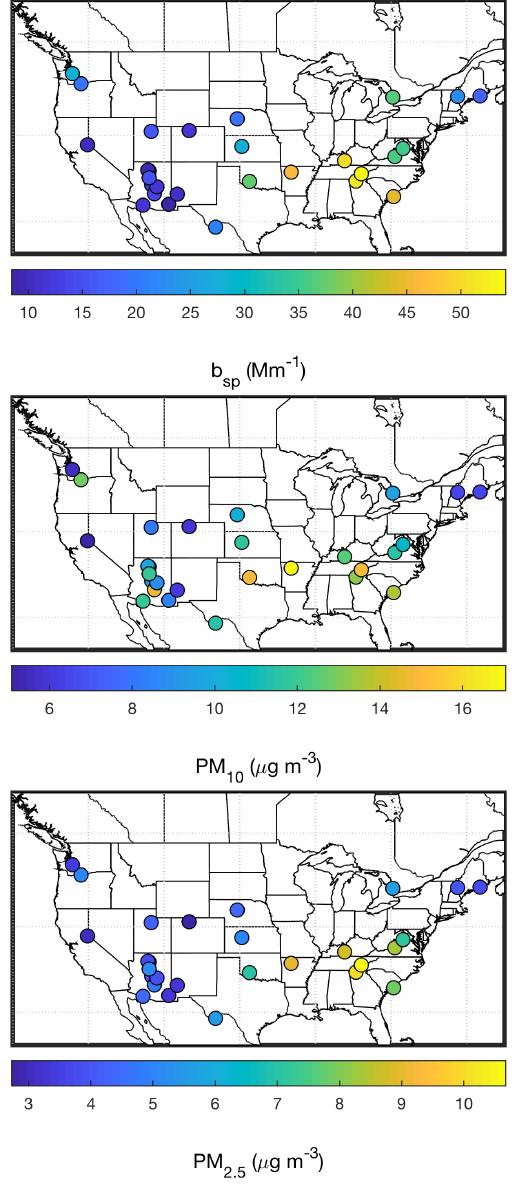
Figure 1. Map of IMPROVE sites with collocated scatter ( b sp ) at 550nm and ambient relative humidity, PM 10 , and PM 2 . 5 measure- ments in North America between 2000 and